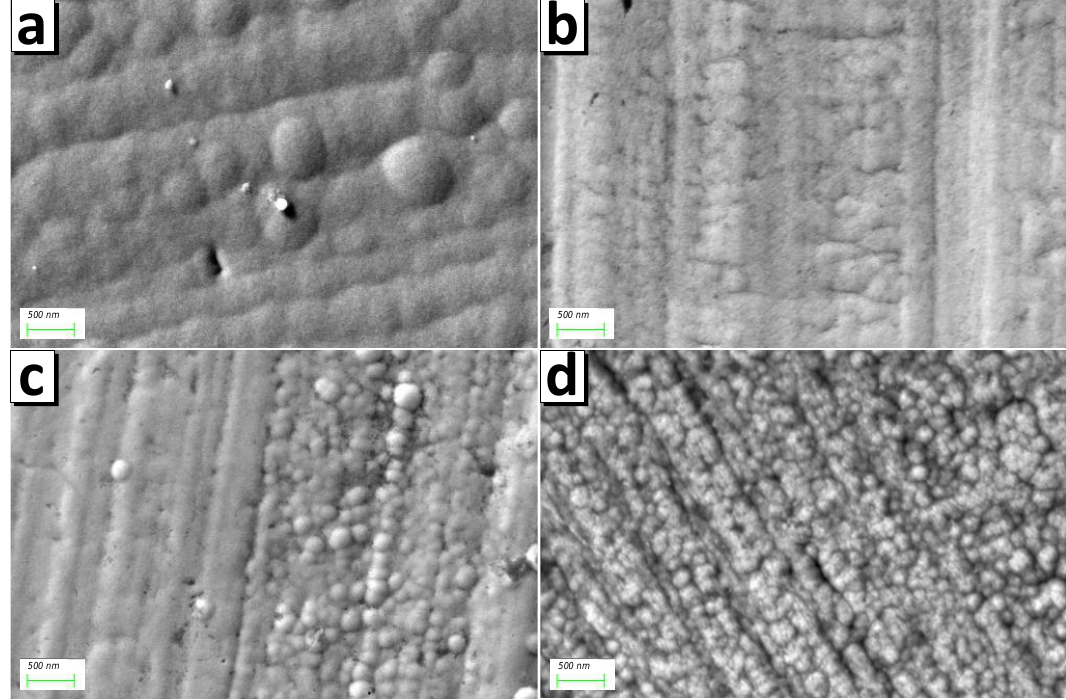
Figure 5. Surface microstructure of FeNi shields investigated using SEM: ( a ) P0, ( b ) P1, ( c ) P0.1, and ( d ) P0.01.